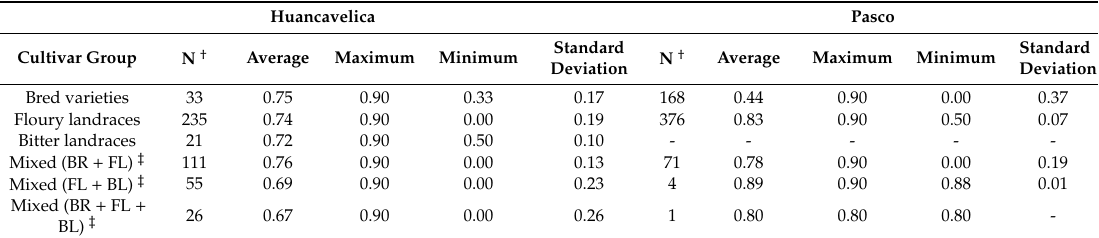
Table 11. Average fallowing rates for exclusive and mixed fields by cultivar group and landscape. Huancavelica Pasco Standard Cultivar Group N † Average Maximum Minimum Deviation